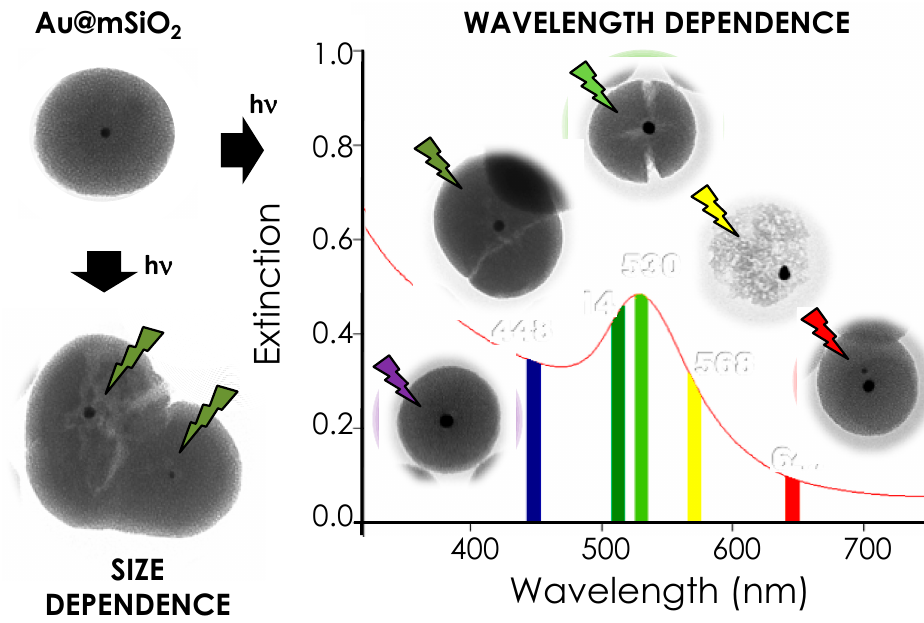
Figure 1. Photodegradation of mesoporous silica nanoparticles encapsulating gold nanocores is dependent on the size of the gold cores and the wavelength of the irradiation.